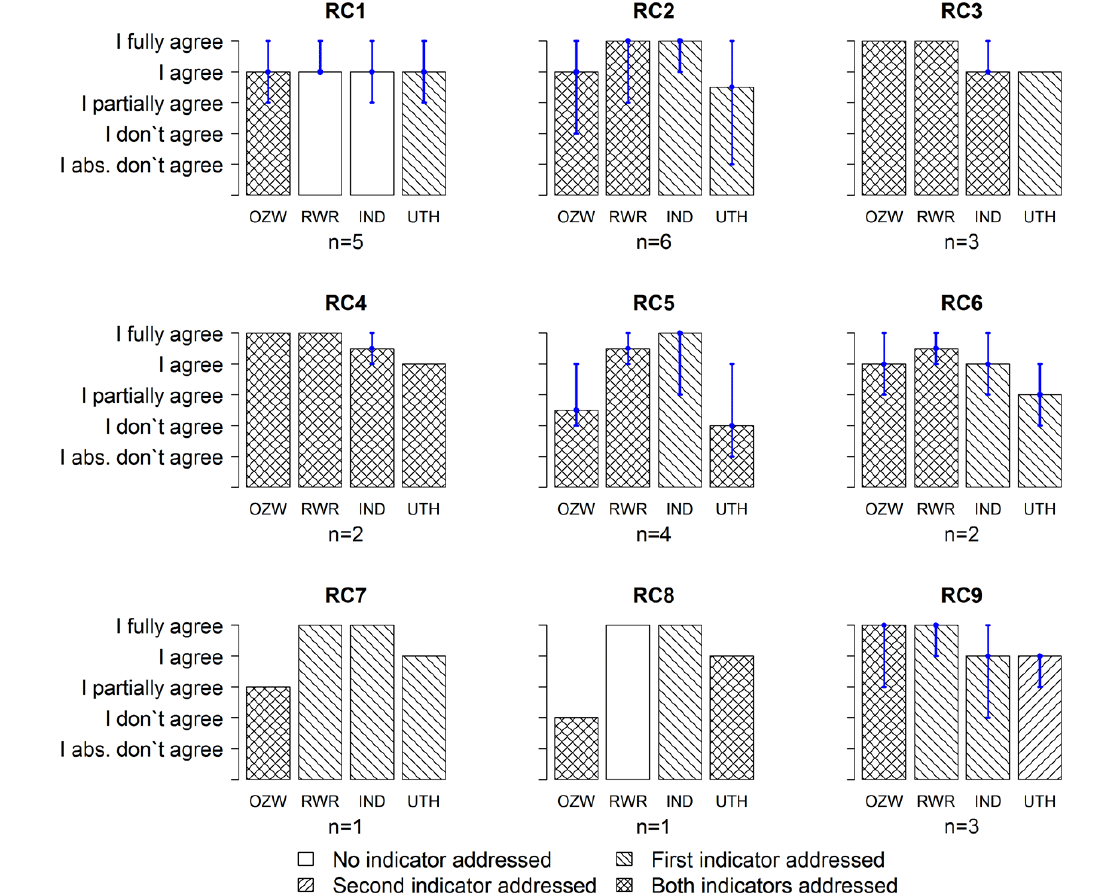
Fig. 6 . Comparison between the implementation of research challenges in the case studies evaluated by the researcher team (see Table 2) and the survey responses of local researchers on the perceived usefulness of scenario assessments to contribute to the research challenges (see Table A2.2 and Table A3.1). Boxes represent the median of the responses per research challenge and case study (n corresponds to the number of responses taken into account for each research challenge). The blue whiskers give the minimum and maximum response value for each research challenge. Filling lines represent the score of indicators evaluated by the researcher team (see Fig. 4). OZW = Oum Zessar watershed, RWR